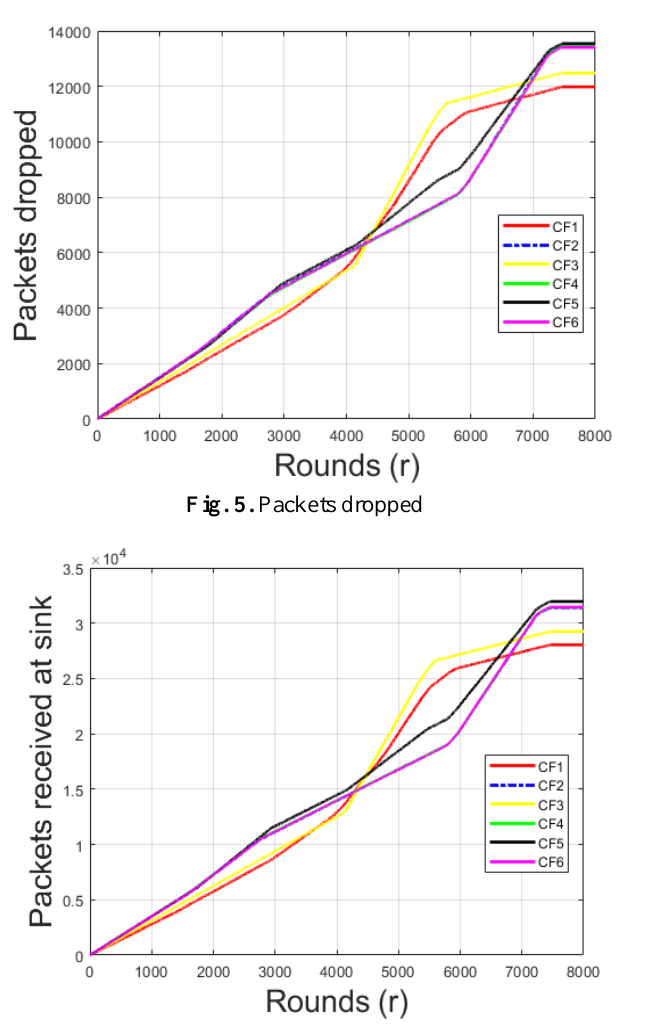
Fig. 6. Packets received at